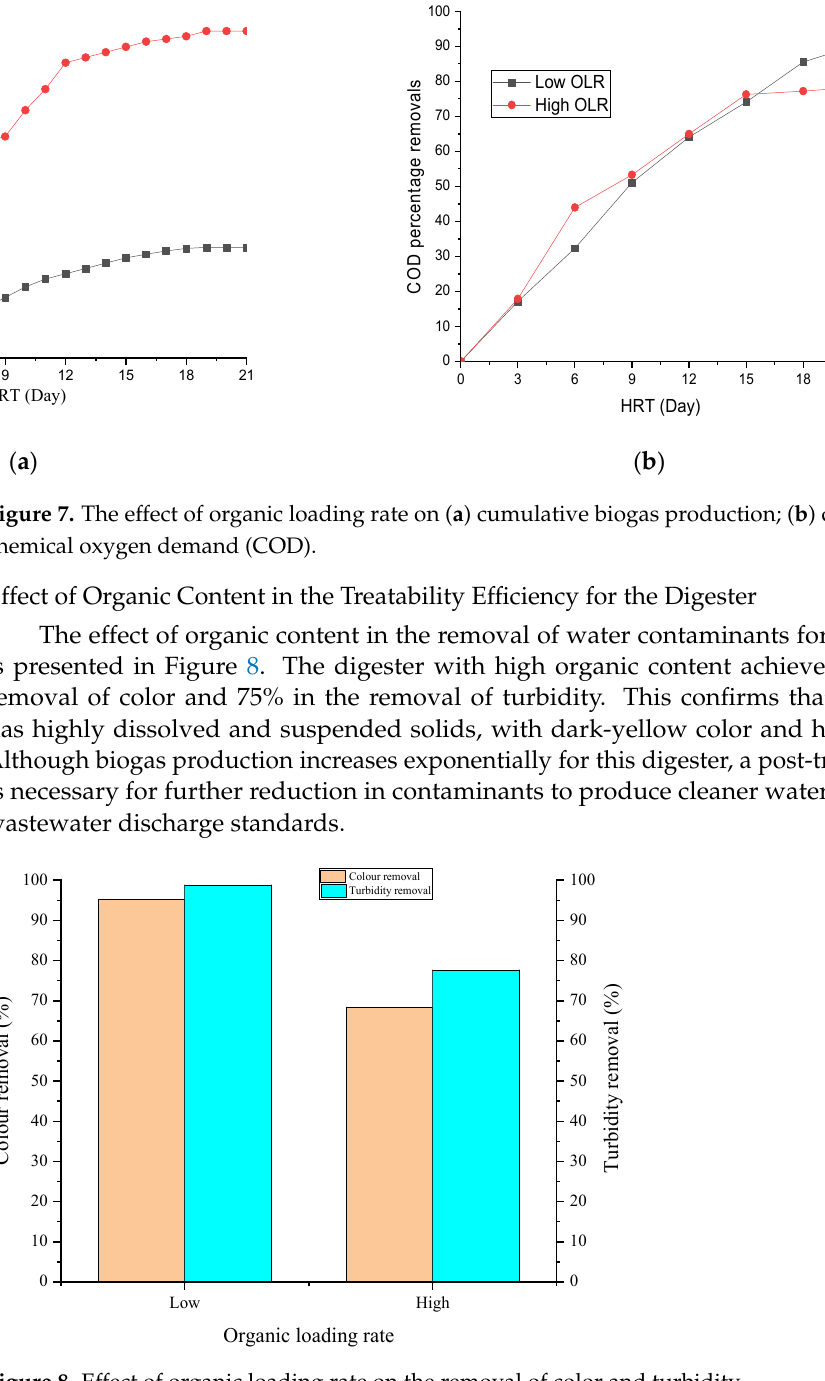
Figure 8. Effect of organic loading rate on the removal of color and turbidity.